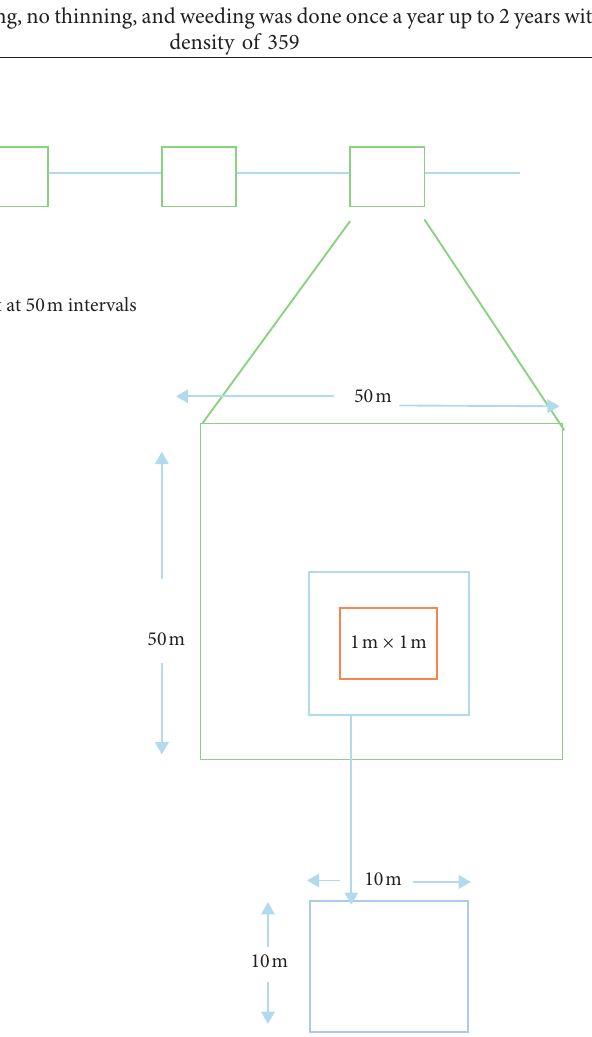
Figure 2: Experimental plot layout of nested plot design; 1 m × 1m for herbs and grasses; 10m × 10m plot for sampling climbers, shrubs, and tree life forms (20cm height < 10cm dbh); and 50m × 50m plot for sampling Tectona grandis trees.